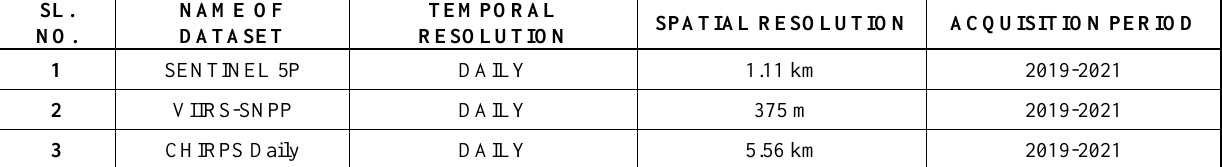
Table 1. Details of datasets used